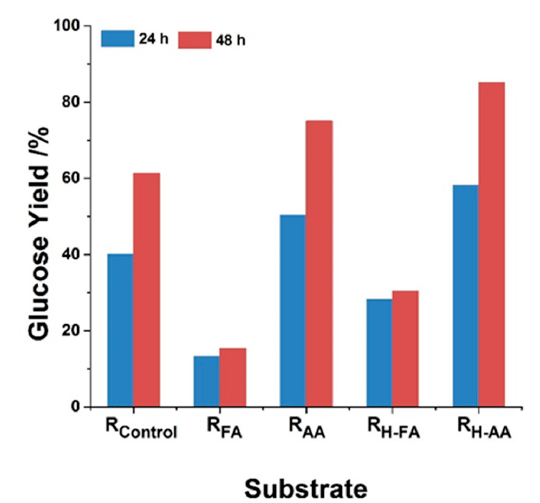
Figure 6. The glucose yield of the substrates after lignin extraction. (H-FA and H-AA were treated by additional acid: 120 °C, 2 h, 1 wt% H 2 SO 4 solution; liquid/solid: 10:1 v/w; enzymatic hydrolysis conditions: concentration of substrate: 5%; 50 °C; 250 rpm; and enzyme (Novozymes Cellic ® ctec2) conditions: concentration of substrate: 5%; 50 ◦ C; 250 rpm; and enzyme (Novozymes Cellic ® ctec2) loading of 15 FPU/g substrates). loading of 15 FPU / g